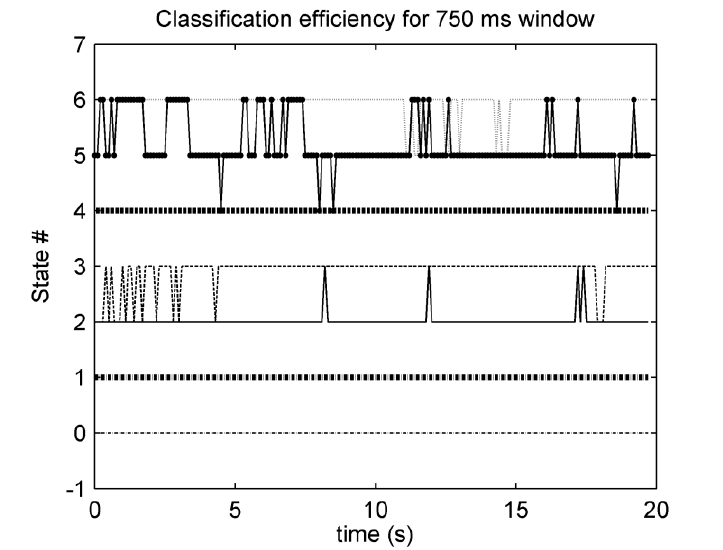
Figure 14. Cross-state graph: classifier efficiency for 7 states (numbered from 0 to 6). State #0 is at rest; #1, #2 and #3 are related to the biceps contraction level, from weak to strong respectively. #4, #5 and #6 are related to the triceps contraction level.